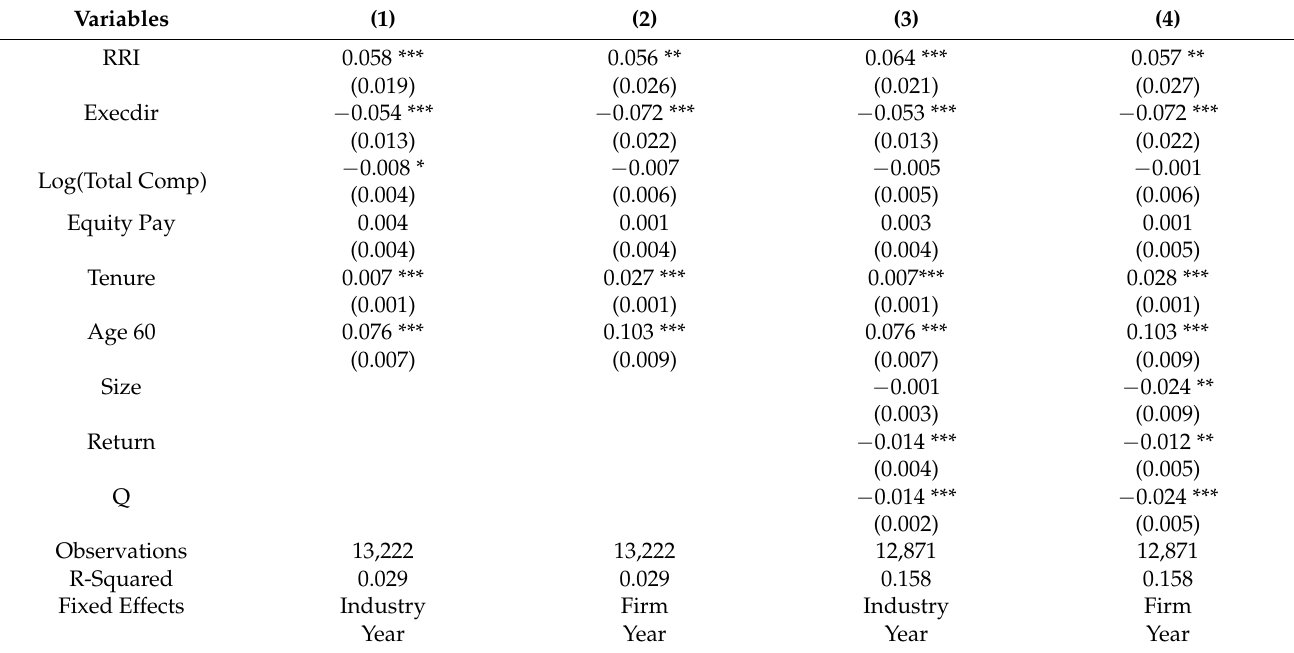
Table 4. Baseline Results. The dependent variable is CEO turnover, the main explanatory variable is the reputational risk index (RRI) for each firm. See Appendix A for variable definitions. Standard errors are clustered by firm and reported in parentheses. *, ** and *** represent statistical significance at the 10%, 5% and 1% level,